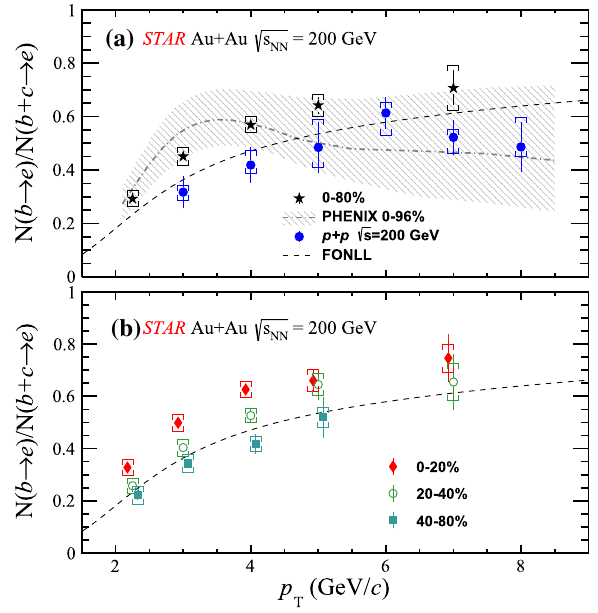
Fig. 8 The measured fraction of bottom hadron decayed electrons, √ f AA s NN = 200 , in intervals of electron p T in Au+Au collisions at b in 0–80% Au+Au collisions compared with the PHENIX GeV. a f AA b measurements [34], and the corresponding fraction f pp in p + p col- √ b s = 200 GeV [59]. b f AA lisions at in three different centrality b intervals. The error bars show statistical uncertainties, and the brackets show the systematic ones. The dashed line shows the central value of the FONLL prediction [45,46]. Data points are plotted along the x -axis at their respective bin centers, except 0–20% and 40–80% centrality classes, which are offset by 75 MeV/ c for clarity